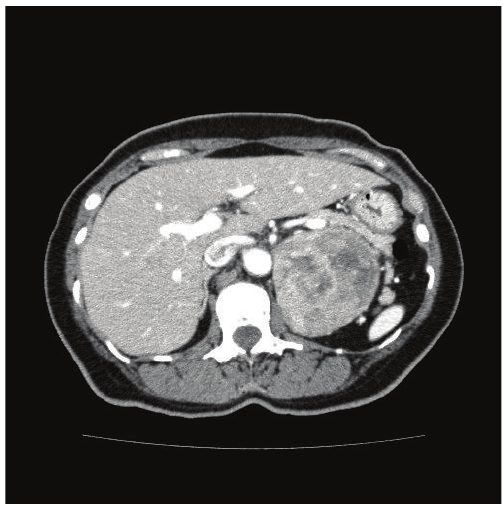
Figure 1: Left adrenal phaeochromocytoma with areas of necrosis and